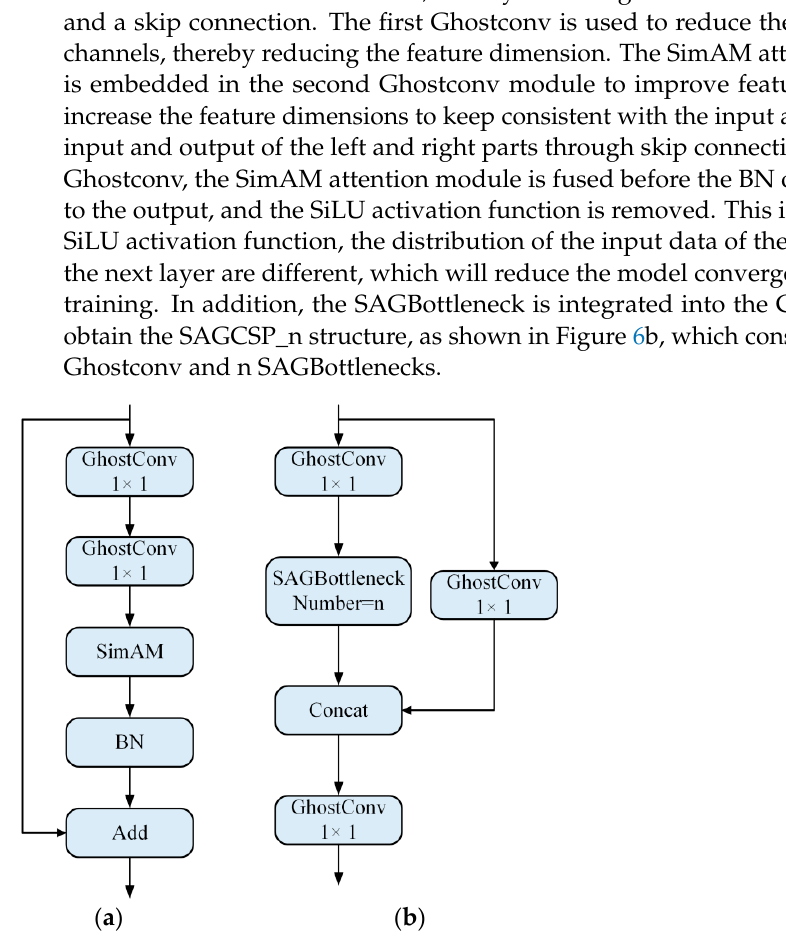
Figure 6. Basic structure of SAG-YOLOv5s: ( a ) SAGBottleneck structure; ( b ) SAGCSP_n